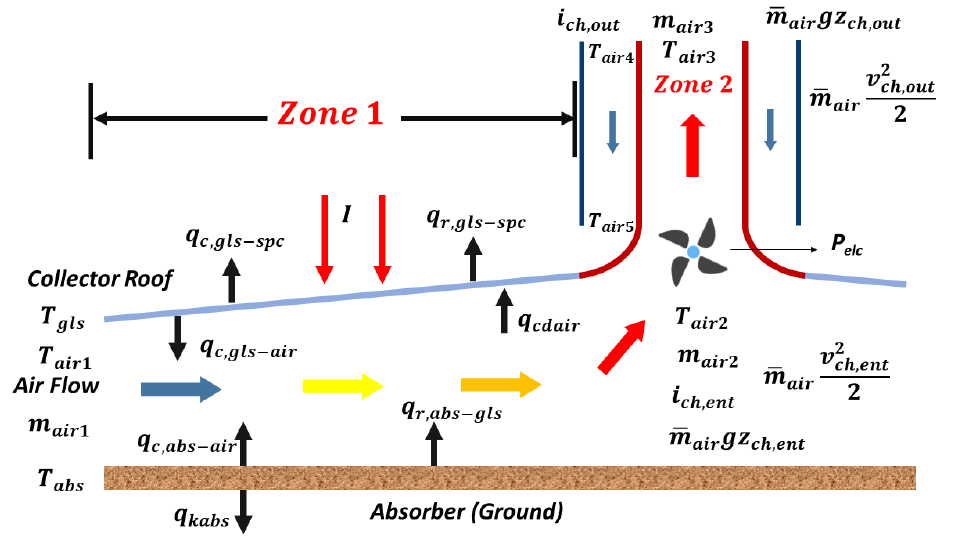
Table 2. Relevant properties of the SDCPP parts.